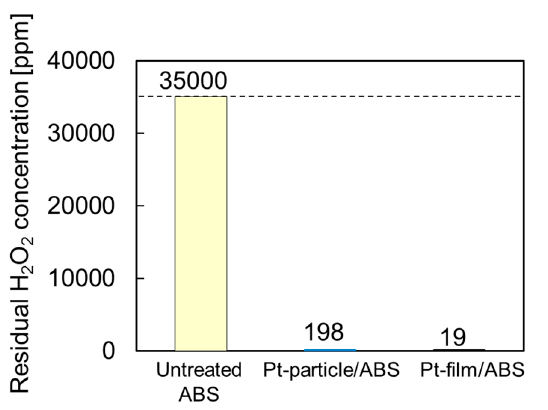
Figure 3. Catalytic activity of the untreated ABS, Pt-particle/ABS, and Pt-film/ABS samples: residual H 2 O 2 concentration after immersion for 360 min.